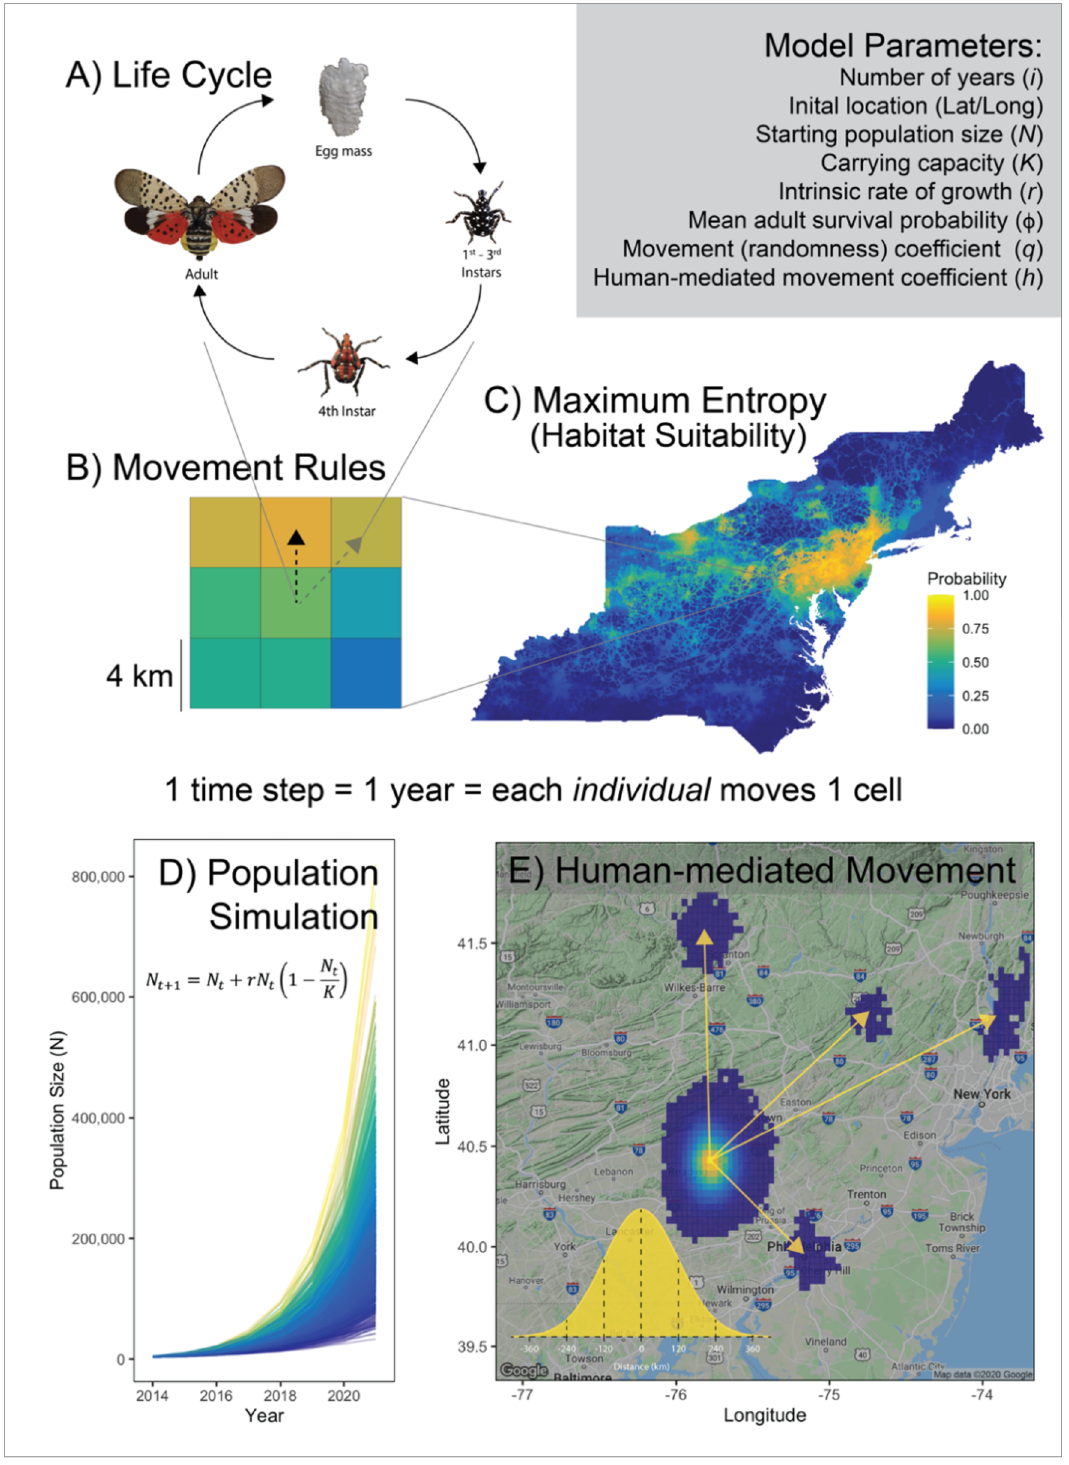
Figure 2. Graphical description of agent-based model showing list of model parameters and model components: ( A ) spotted lanternfly annual life cycle, ( B ) simple movement rules corresponding to annual movement (i.e., 1 year or time step) of a single individual (agent), ( C ) map of Maxent model-based estimate of spotted lanternfly potential probability of occurrence based on several environmental and landscape variables, ( D ) examples of simulated exponential population growth dynamics, and ( E ) depiction of human-mediated movement events leading to newly established infestations. The inset maps and figures were produced using the ‘ggplot2’ (ver. 3.3.6; https:// cran.r- proje ct. org/ web/ packa ges/ ggplo t2/ index. html), ‘ggmap’ (ver. 3.0.0.903; ver. 3.0.0.903; https:// cran.r- proje ct. org/ web/ packa ges/ ggmap/ index. html), and ‘cowplot’ (ver. 1.0.0; https:// www. rdocu menta tion. org/ packa ges/ cowpl ot/ versi ons/1. 1.1) packages in